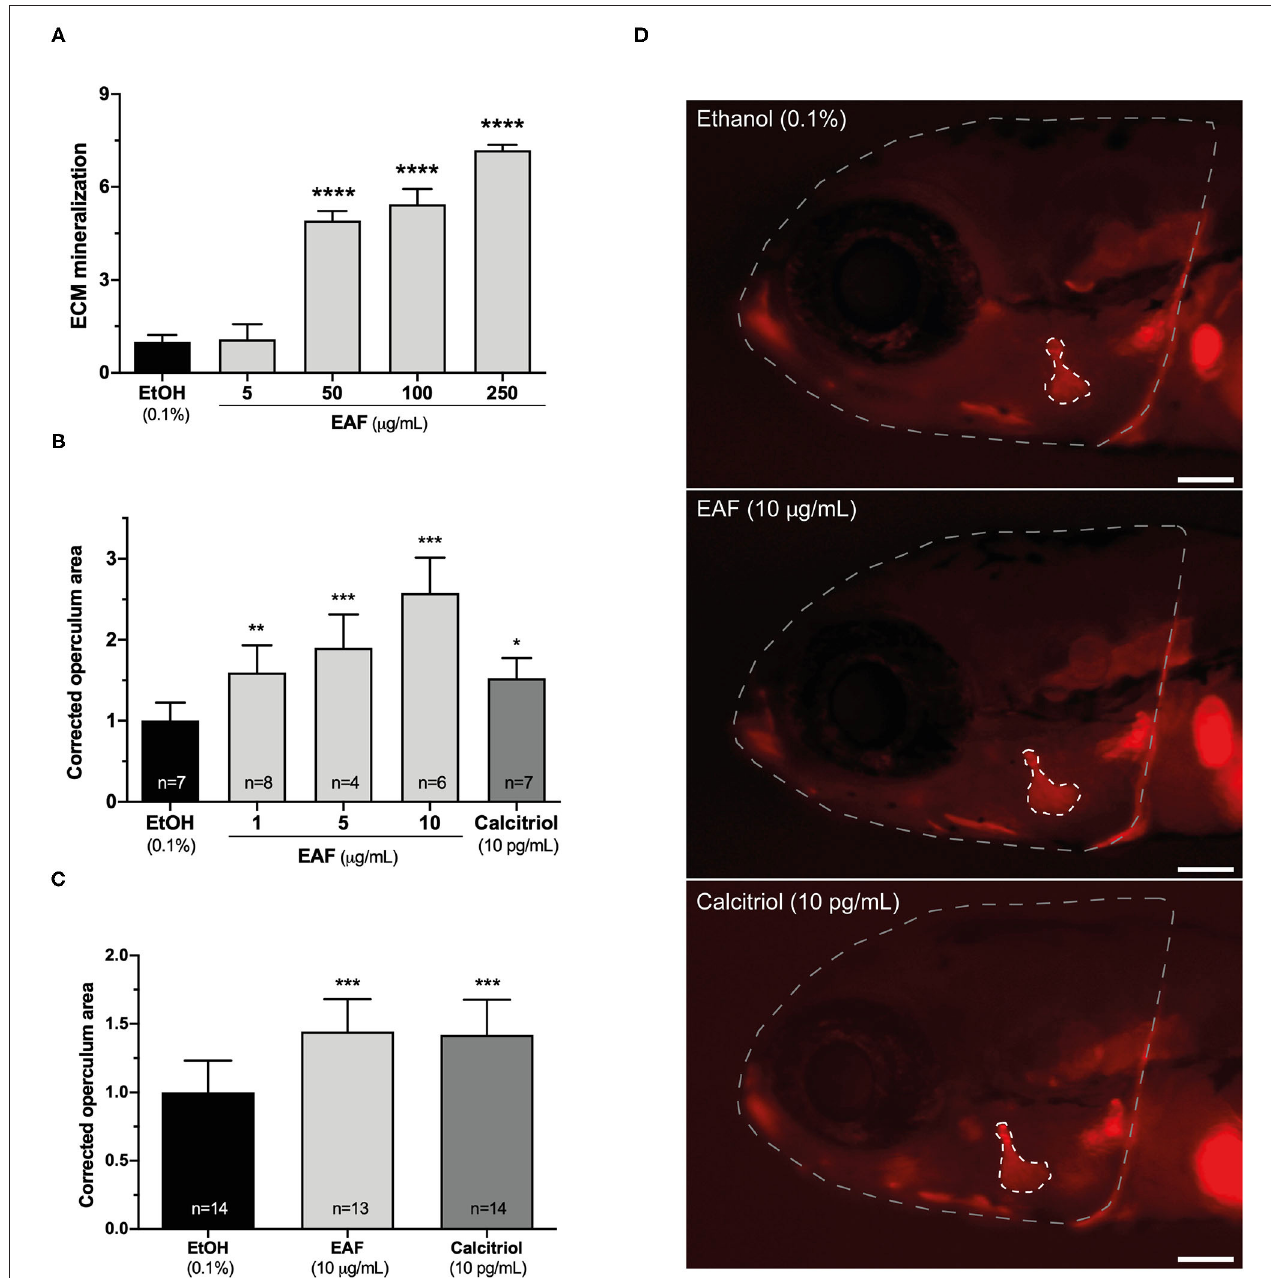
FIGURE 3 | Mineralogenic and osteogenic activities of S. alterniflora ethyl acetate fraction. (A) EAF mineralogenic activity was determined in VSa13 cell cultures induced for ECM mineralization for 17 days while exposed to 5, 50, 100 and 250 µ g/mL of the extract or 0.1% ethanol ( n = 4). (B,C) EAF osteogenic activity was determined in 9-dpf zebrafish larvae exposed for 48h to 1, 5, 10 µ g/mL of EAF, 10 pg/mL of calcitriol or 0.1% ethanol ( n > 4) (B) and in 3-dpf zebrafish larvae exposed for 72h to 10 µ g/mL of EAF, 10 pg/mL of calcitriol or 0.1% ethanol ( n > 13) (C) . (D) Fluorescence images of alizarin red S-stained larvae exposed to the different conditions/treatments. Areas of the head and operculum are evidenced by dashed lines. White bar represents 100 µ m. Values are presented as mean ± standard deviation. Asterisks indicate values significantly different from the control values (one-way ANOVA followed by Dunnett’s multiple comparison test; * p < 0.05, ** p < 0.01, *** p < 0.001, **** p <